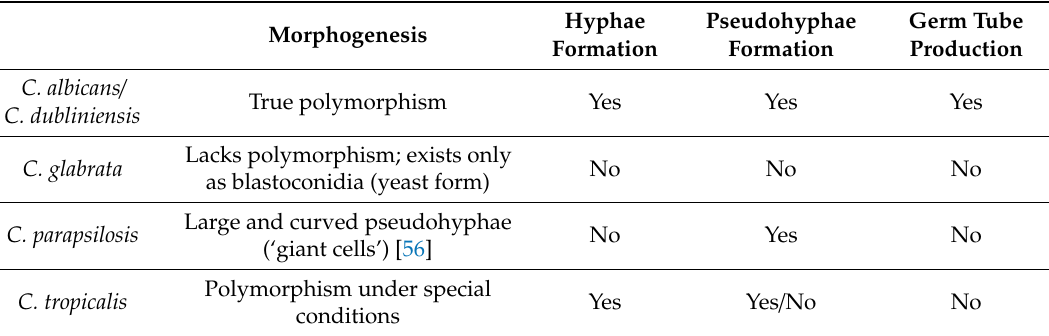
Table 2. The morphological plasticity of Candida